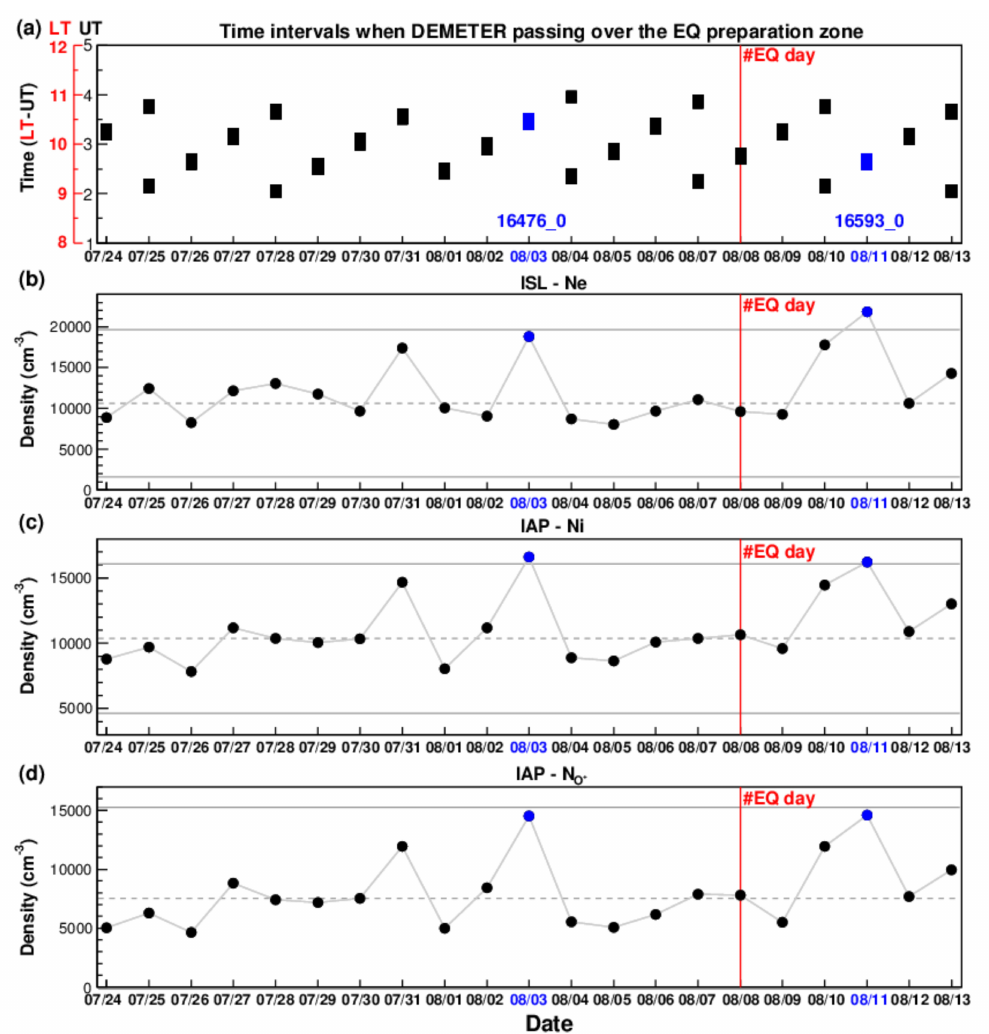
Figure 5. The plasma features above the epicenter. Subpanel ( a ) indicates the time intervals when satellite the DEMETER passed over the EQ preparation zone from 24 July to 13 August 2007. The electron density ( b ), ion density ( c ) and O + density ( d ) detected by DEMETER during the above time intervals, respectively. The gray, dashed and straight lines represent the medians, the lower and the upper confidence bounds of plasma parameters, respectively. The blue dots indicate the values detected on 3 August and 11 August with extreme anomalies. The red vertical lines indicate the earthquake